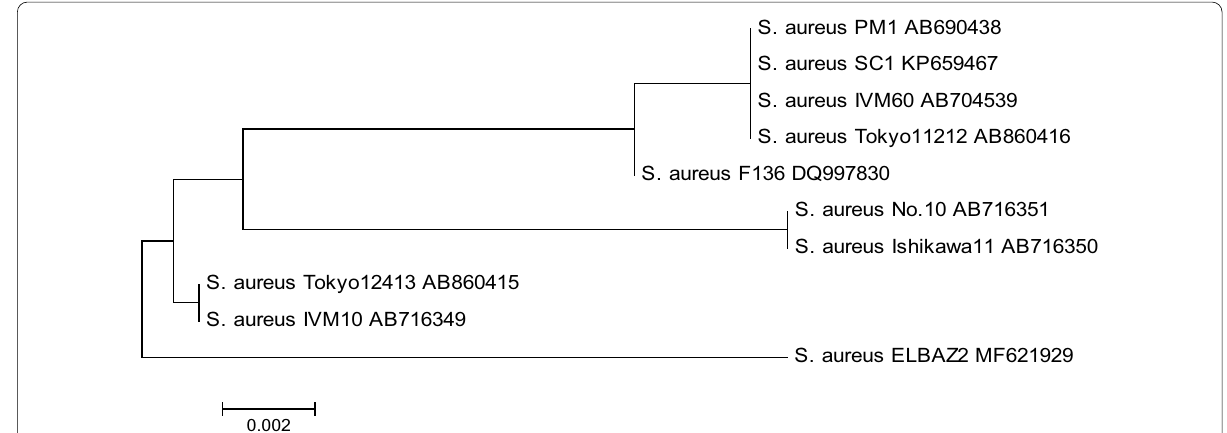
Fig. 6 The minimum evolution distance analysis phylogenetic tree of SEB gene encoding S. aureus MF563555 compared with other strains of SEB encoding gene available in